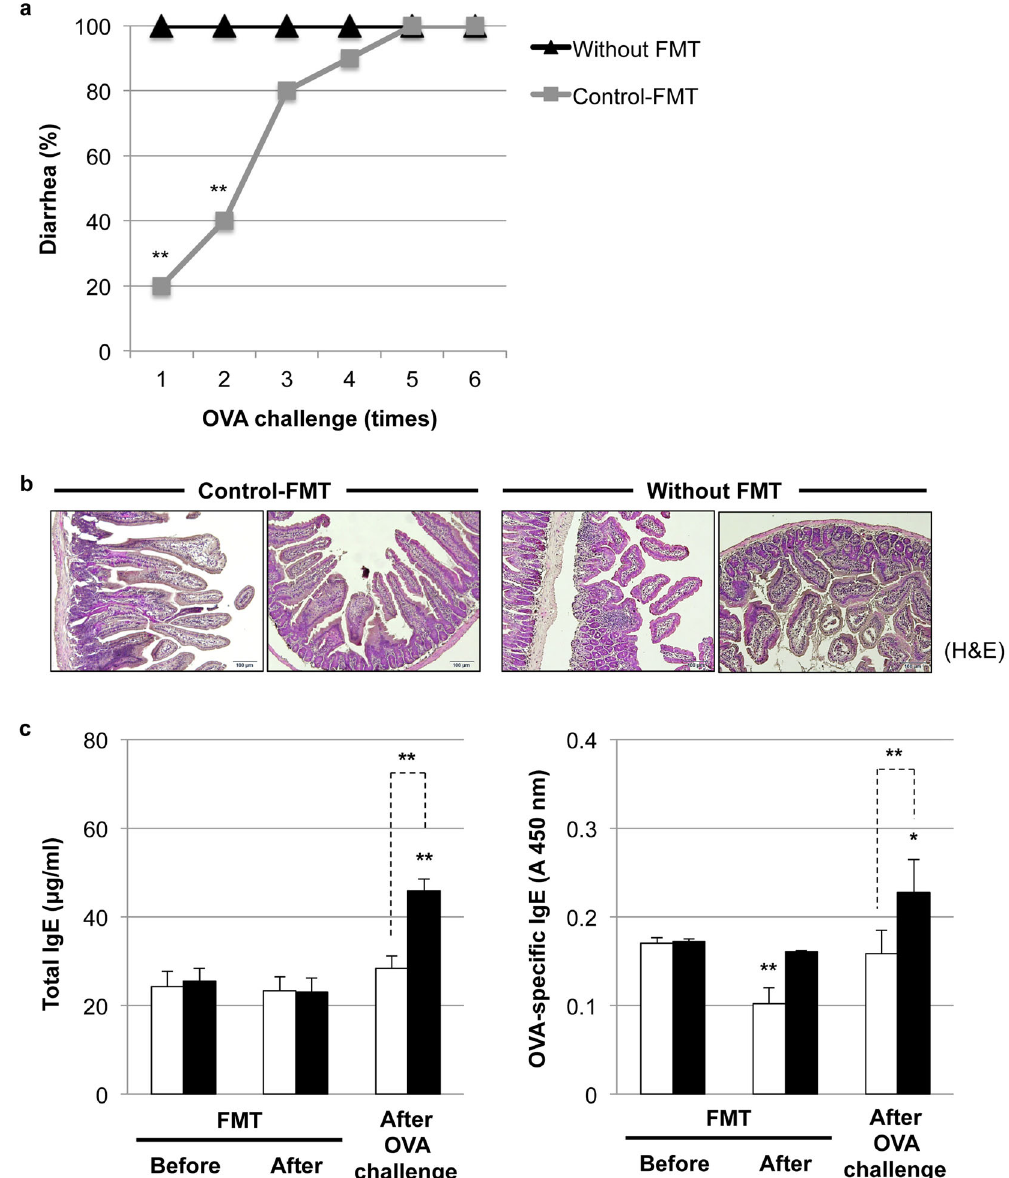
Fig. 8 Application of fecal microbiota transplantation (FMT) for the therapeutic modulation of diseased microbiota. a Therapeutic modulation of gut microbiota by FMT in FA mice. After the development of FA and following antibiotic-induced dysbiosis, FMT with control donor feces (control-FMT) was administered to FA mice ( n = 10). FA mice without FMT ( n = 5) were set as a comparison. Allergic diarrhea was assessed visually by monitoring mice for 30 min after each i.g. exposure. ** P < 0.01 vs. FA mice without FMT (Tukey ’ s multiple comparisons test). b Histological evaluation of the intestines of FA mice with/without control-FMT after the 6th OVA challenge. The pictures at ×100 magni fi cation are representative of ten individuals in each group. H&E hematoxylin and eosin staining. Scale bar: 100 μ m. c Reduced expression of total and OVA-speci fi c IgE after the 6th OVA challenge in FA mice with control-FMT (white bar). Black bar: FA mice without FMT. Values are presented as the mean ± SD of ten individuals in each group. *, **, P < 0.05 and 0.01 vs. FA mice before FMT or the indicated pair, respectively (Student ’ s t